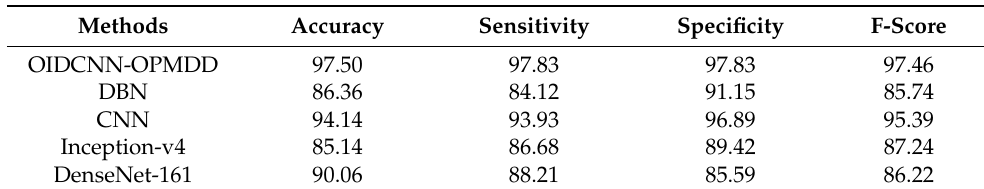
Table 6. Comparative analysis of OIDCNN-OPMDD approach with existing algorithms. [10,19].